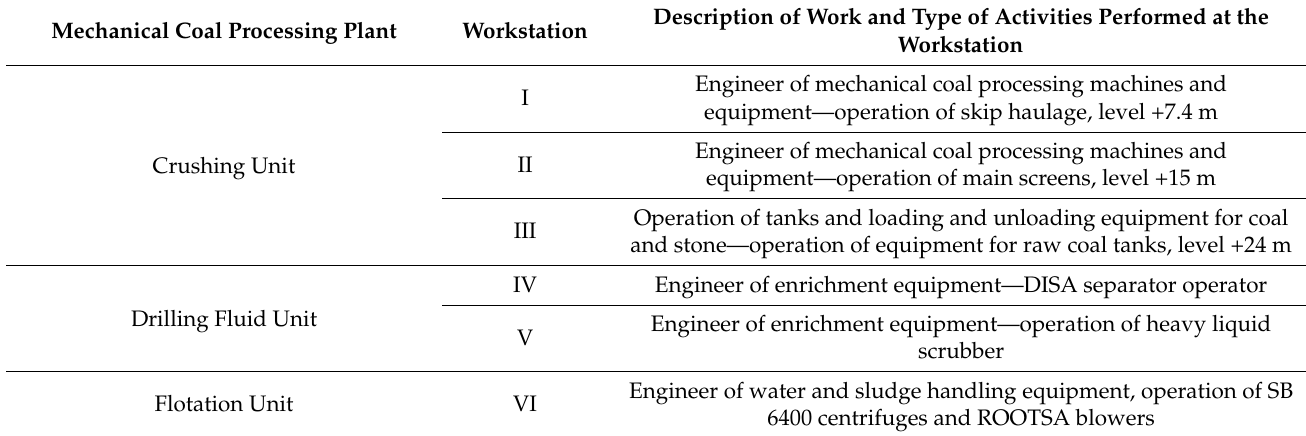
Table 1. Places and workstations for noise